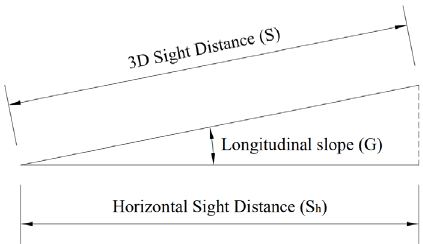
Figure 5. Relationship between three-dimensional and horizontal S.S.D. in straight slope.